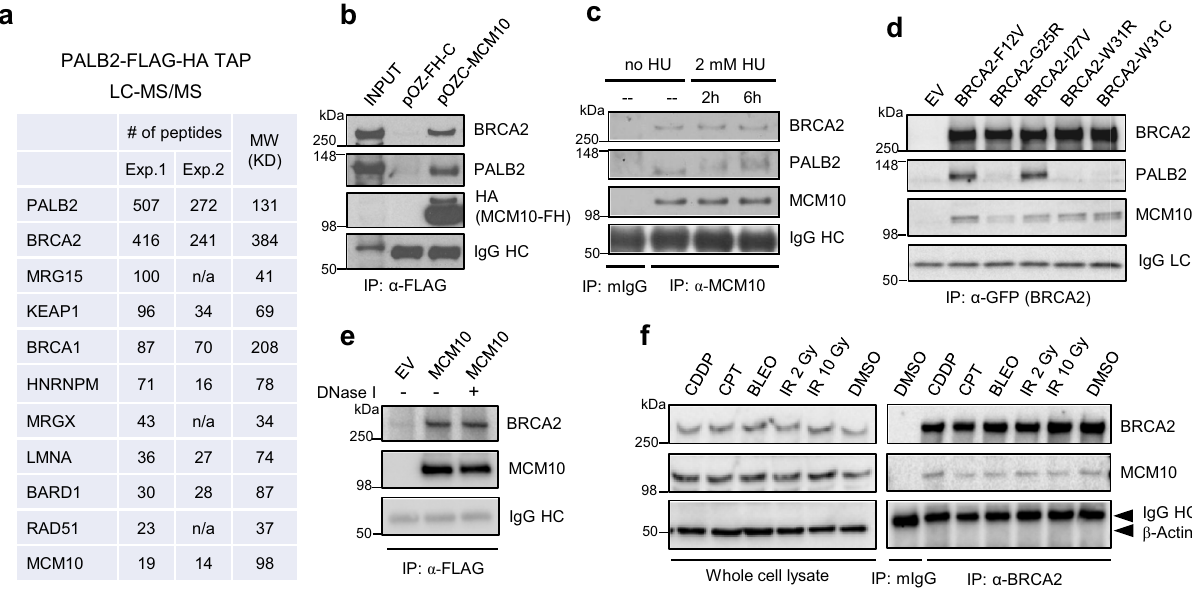
Fig. 4 Identi fi cation of MCM10 as a BRCA2-ineracting protein. a Numbers of tryptic peptides obtained from two independent PALB2 tandem af fi nity puri fi cation (TAP)-LC-MS/MS experiments. b Co-IP of endogenous PALB2 and BRCA2 with ectopic MCM10. FLAG-HA-tagged MCM10 was transiently overexpressed in 293T cells and IPed with anti-FLAG. c Co-IP of endogenous MCM10 and endogenous PALB2 and BRCA2 in unperturbed and HU-treated U2OS cells. d Co-IP of GFP-tagged BRCA2 variants and FLAG-HA-tagged MCM10 overexpressed in 293T cells. e Association of endogenous BRCA2 with ectopic FLAG-HA-tagged MCM10. The procedure was performed as in ( b ) except that the fi nal IP material was treated with DNase I on the beads and then washed before being subjected to western blotting. f Co-IP of BRCA2 and MCM10 in S-phase-synchronized U2OS cells at 3 h after treatment with DMSO, 10 Gy of IR, 2 Gy of IR, BLEO (1 µ M), CPT (1 µ M), or cisplatin (CDDP, 1 µ M). Cells were synchronized in the S phase by a single thymidine block for 24 h and released for 2 h prior to the treatments. For ( b – f ), similar results were obtained in n = 3 independent experiments. Source data are provided as a Source Data fi